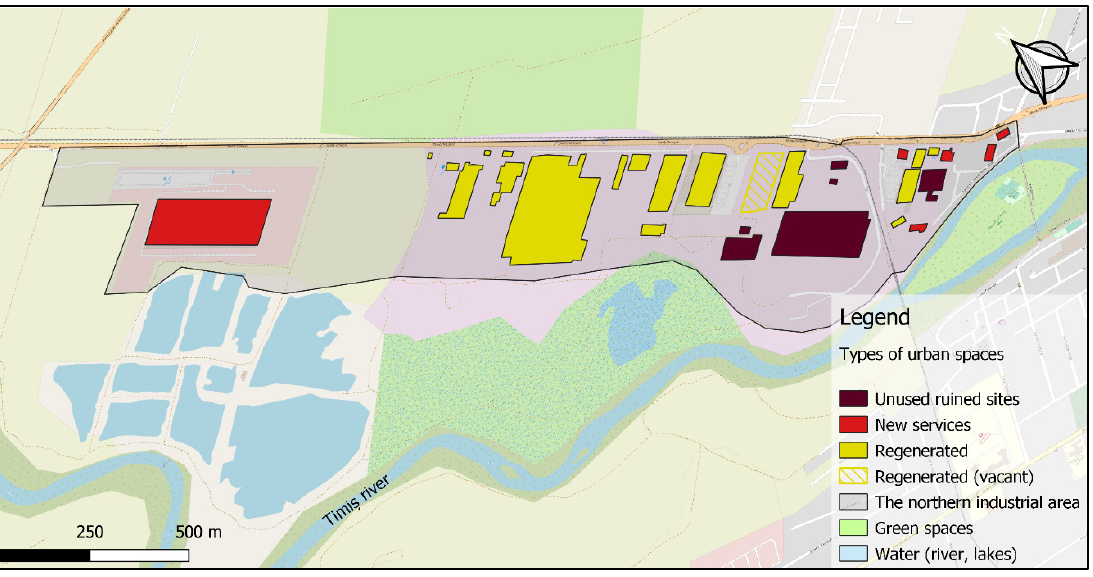
Figure 4. Mapping the types of the urban spaces in the northern industrial area of Lugoj Municipality, 2022.